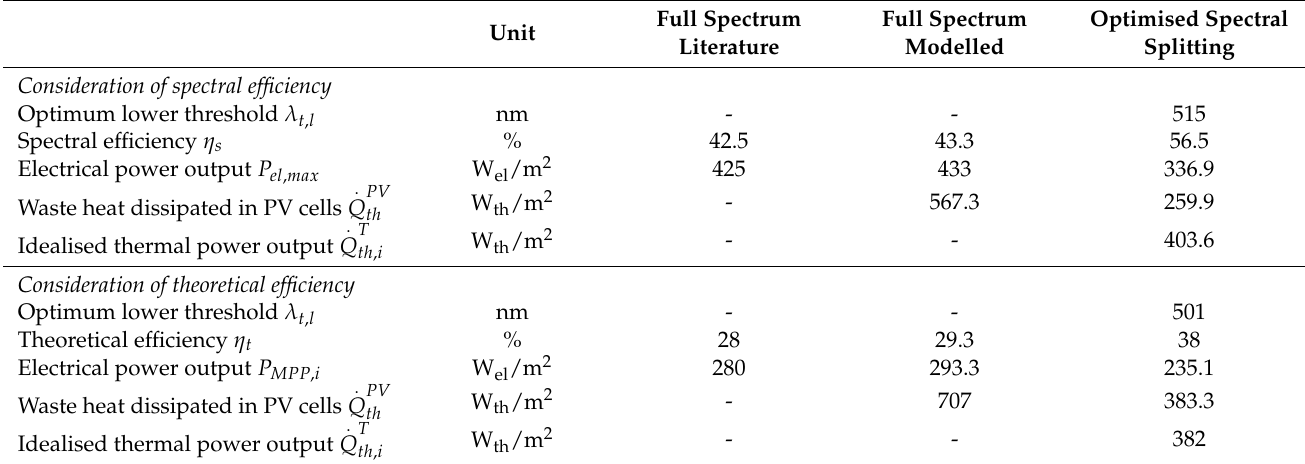
Table 3. Comparison of key parameters at full spectrum and at optimum Spectral Splitting configuration for CdTe PV technology.